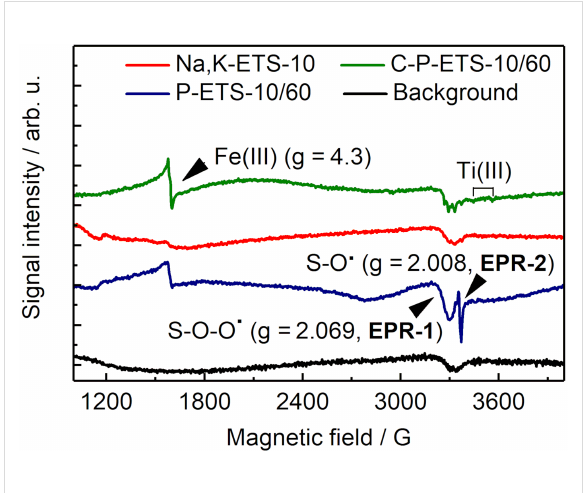
Figure 14: The EPR spectra measured with Na,K-ETS-10 (red), P-ETS-10/60 (blue) and C-P-ETS-10/60 (green) at 70 K. The back- ground spectrum taken on an empty sample tube is presented for com- parison (black).